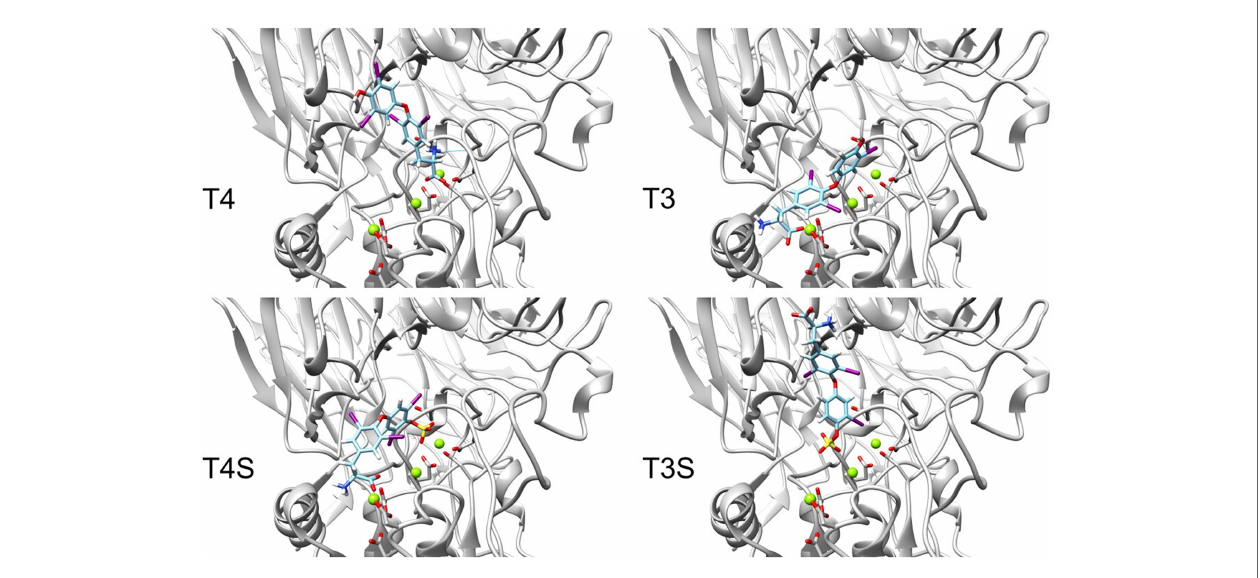
FIGURE 4 | Docking structures of T4, T3 to the integrin a v b 3 binding site in comparison to their sulfated forms. Integrin ’ s binding site backbone (ribbons) and side chains (sticks) are colored gray with oxygen atoms in red and nitrogen in blue. Comparison between the docked structure of T3 (ZINC000003830999), T4 (ZINC000003830993),